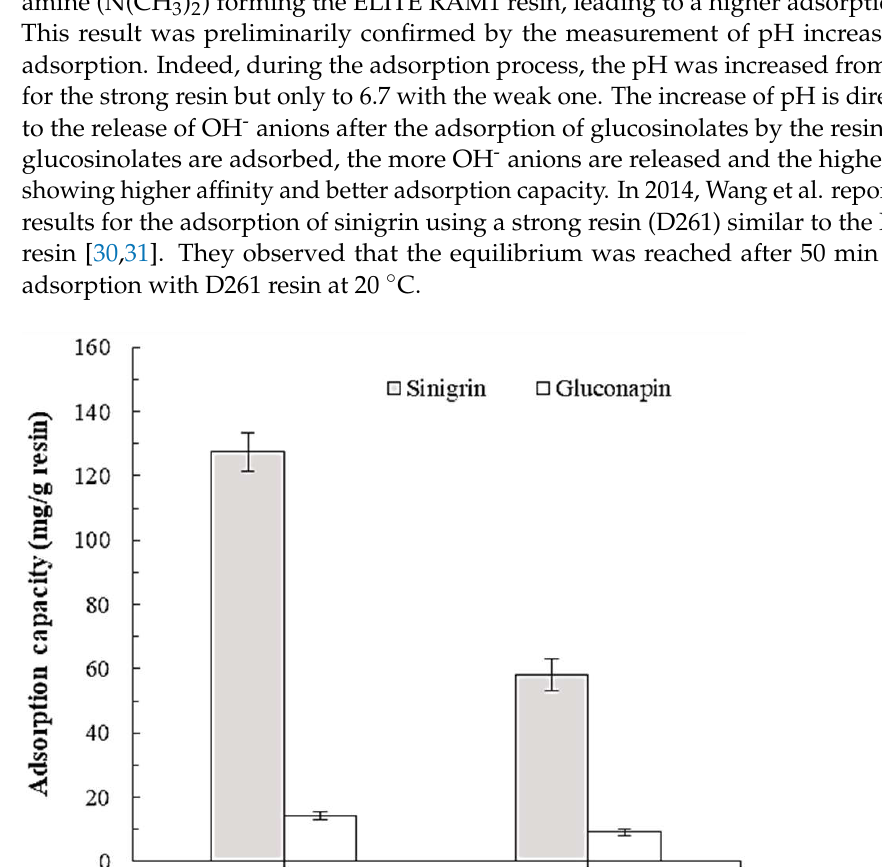
Figure 5. FTIR spectra of (1) standard of sinigrin (2) new PA312LOH resin before its use (3) resin after adsorption (4) resin after desorption. Considering the previous analysis, the mechanism of adsorption/desorption of the strongly basic resin PA312LOH can be illustrated by Figure 6.